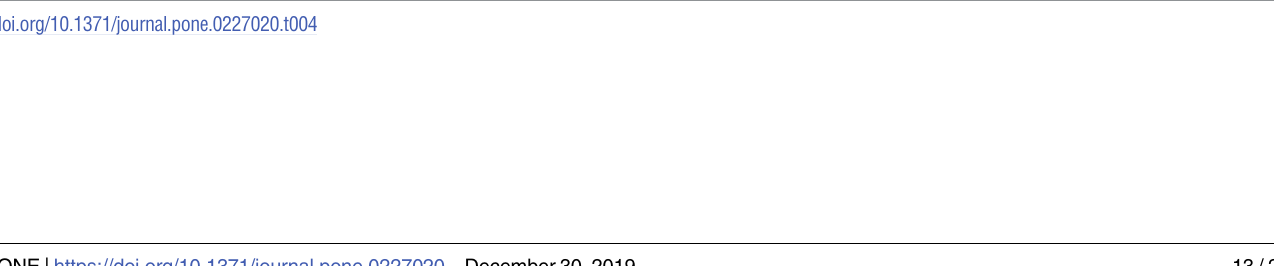
a, represents fold changes calculated from log 2 of RPKM values of experimental samples (100/100, uniform salinity; 0-0/200 and 200-0/200, non-saline and high saline root sides of non-uniform salinity treatments, respectively) vs those of